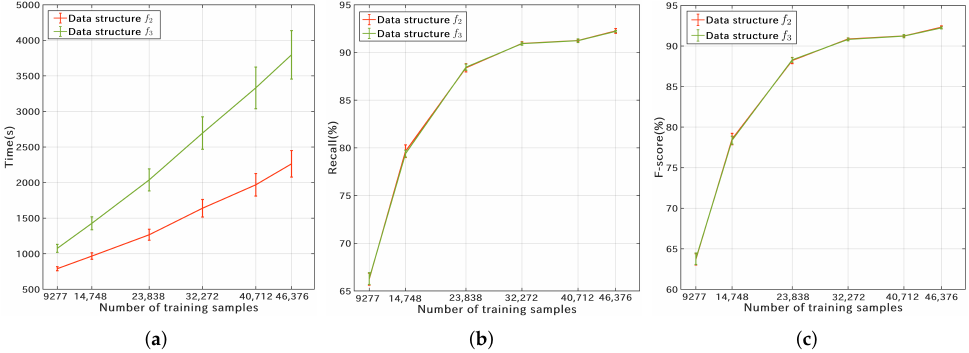
Figure 15. Cross-validation results of the RF classifier on the Pangolin training dataset S P time cost per cross-validation; ( b ) the recall rates of the RF classifier on data structures f 2 and f 3 ; ( c ) the F-scores of the RF classifier on data structures f 2 and f 3